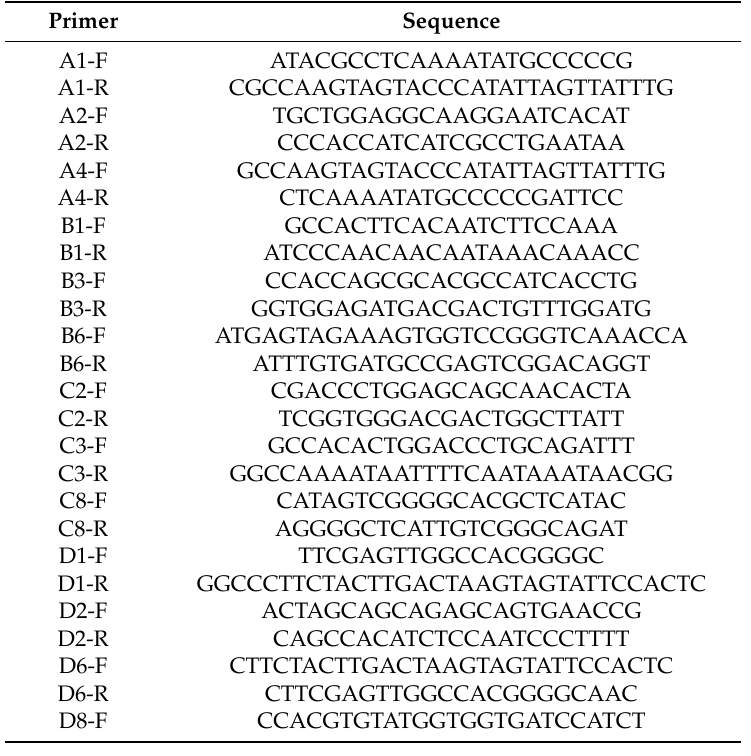
Table 2. Primers designed according to the specific Pistacia chinensis